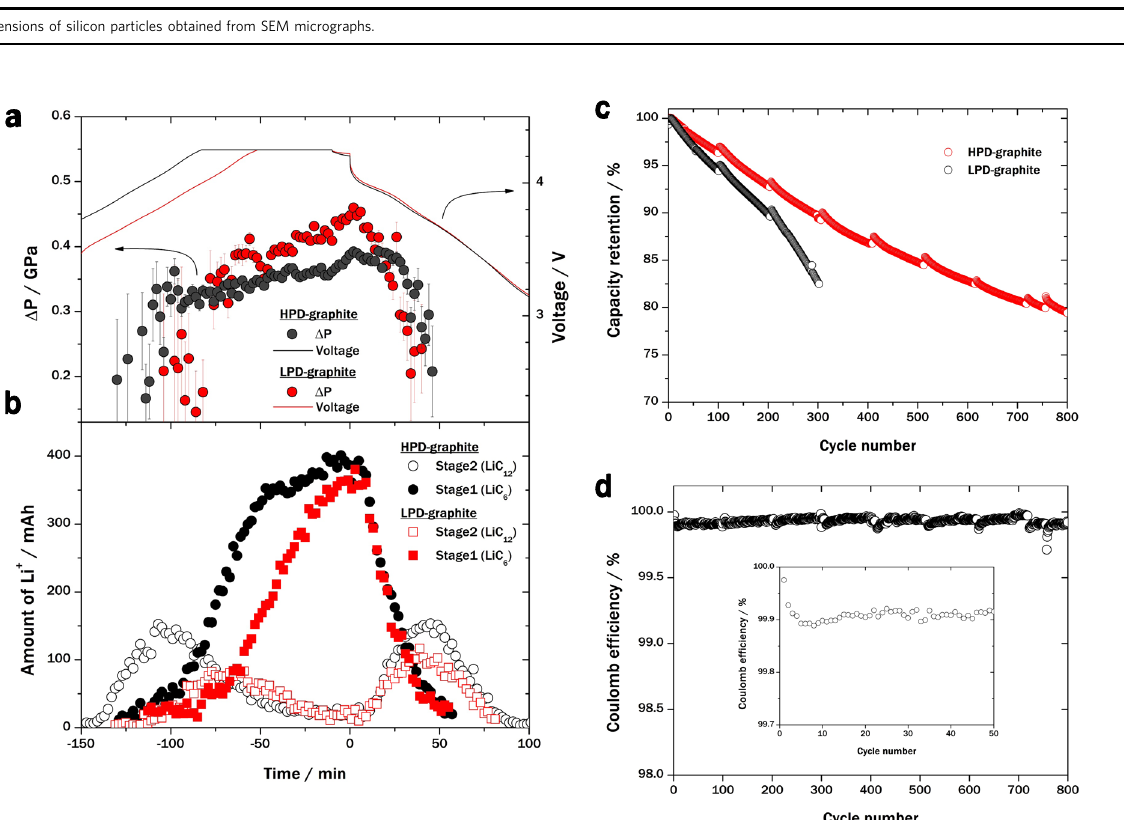
Fig. 4 Capacity degradation of graphite due to volume expansion of Li x Si. a Evolution of pressure on graphite ( Δ P ; circles) and voltage (lines) of Cells C and D, respectively, during cycling. The pressure develops owing to the expansion of Li x Si and subsequent Li + intercalation into graphite. The discharge start time is set to 0 min. b Amounts of Li + in graphite during stage 1 ( fi lled) and stage 2 (open) in Cells C and D, respectively. c Dependence of cycling performance of prismatic cells with a capacity of 8.7 Ah on the physical properties of graphite. Black circle: High pellet density (HPD)-graphite; red circle: low pellet density (LPD)-graphite. d Coulombic ef fi ciency of prismatic cell using LPD-graphite. Inset: magni fi ed view of the fi rst 50 cycles. The